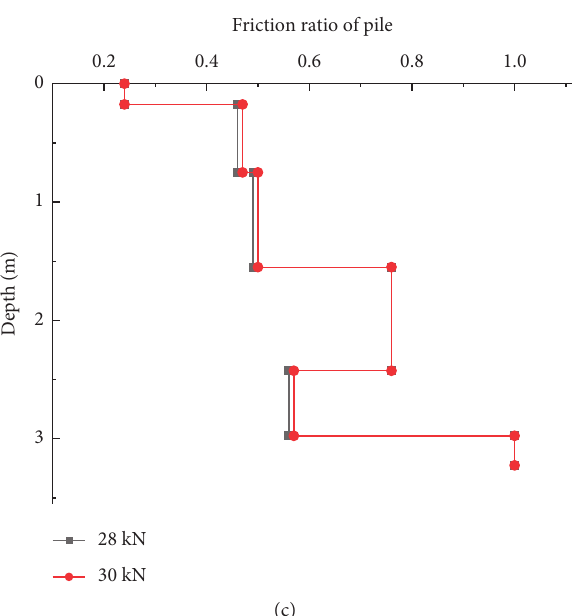
Figure 8: Distribution curve of pile friction ratio along depth. (a) Elastic stage. (b) Elastic-plastic stage. (c) Limit